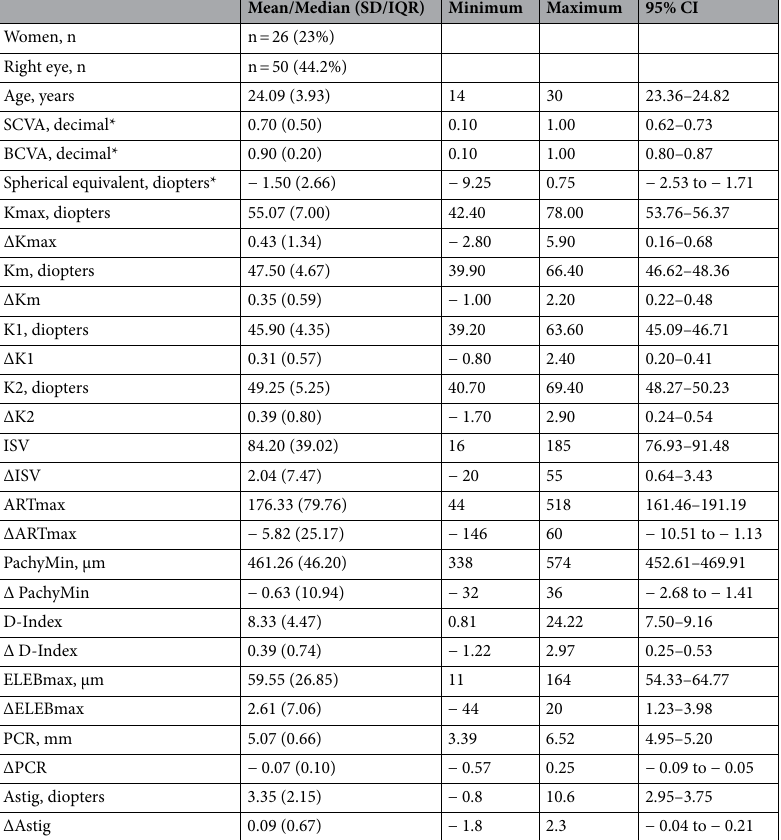
Table 1. Summary of sample characterization of patients and characterization of tomographic indices. Results are expressed as mean ± SD for continuous variables (*results expressed as median ± IQR), 95% confidence intervals (95% CI) and female gender and right eyes are expressed as count and percentage. SCVA spectacle corrected visual acuity, BCVA best corrected visual acuity, Kmax maximum keratometry, Km mean keratometry, K1 keratometry of flat meridian, K2 keratometry of steepest meridian, ISV index of surface variance, ARTmax Ambrósio relational thickness maximum, PachyMin minimum pachymetry, D-Index Belin/ Ambrósio D-Index, ELEBmax maximum elevation of corneal back surface, PCR posterior radius of curvature from the 3.0 mm centered on the thinnest point, Astig corneal astigmatism. Δ represents the variations of parameter readings between the first and the second measurement after 12 ± 3